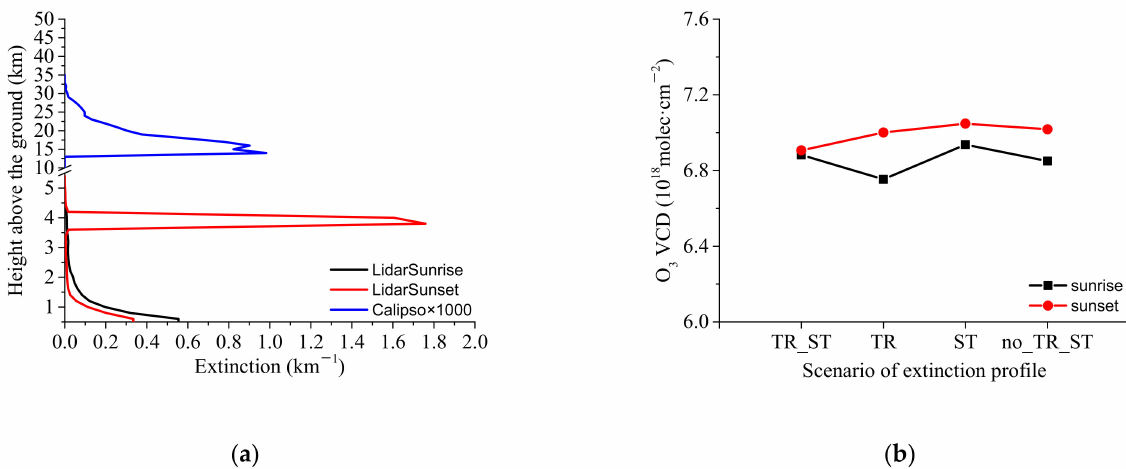
Figure 7. ( a ) Vertical aerosol extinction profiles as well as ( b ) O 3 VCDs derived from the Langley plot method. The black and red curves denote profiles for the height range from 0.5 to 5 km, measured by the 355 nm Lidar at sunrise and sunset on 30 August 2020. The blue curve denotes the extinction profile at 532 nm in the stratosphere (multiplied by a factor of 1000) observed by the Calipso satellite instrument in July 2020. The black curve with squares and the red curve with dots denote the O 3 VCDs during sunrise and sunset, respectively, for the different aerosol scenarios: TR_ST (combination of LidarSunrise and Calipso), TR (LidarSunrise for sunrise and LidarSunset for sunset, without the stratospheric extinction profile), ST (Calipso, without the tropospheric extinction profile), and no_TR_ST (without tropospheric and stratospheric extinction profiles). Note that the extinction at the lowest layer, where the Lidar observations are insensitive (0 to 0.5 km), is set as a constant value (the same as the lowest valid value measured by the Lidar). The default aerosol extinction at the other heights is set to 0.